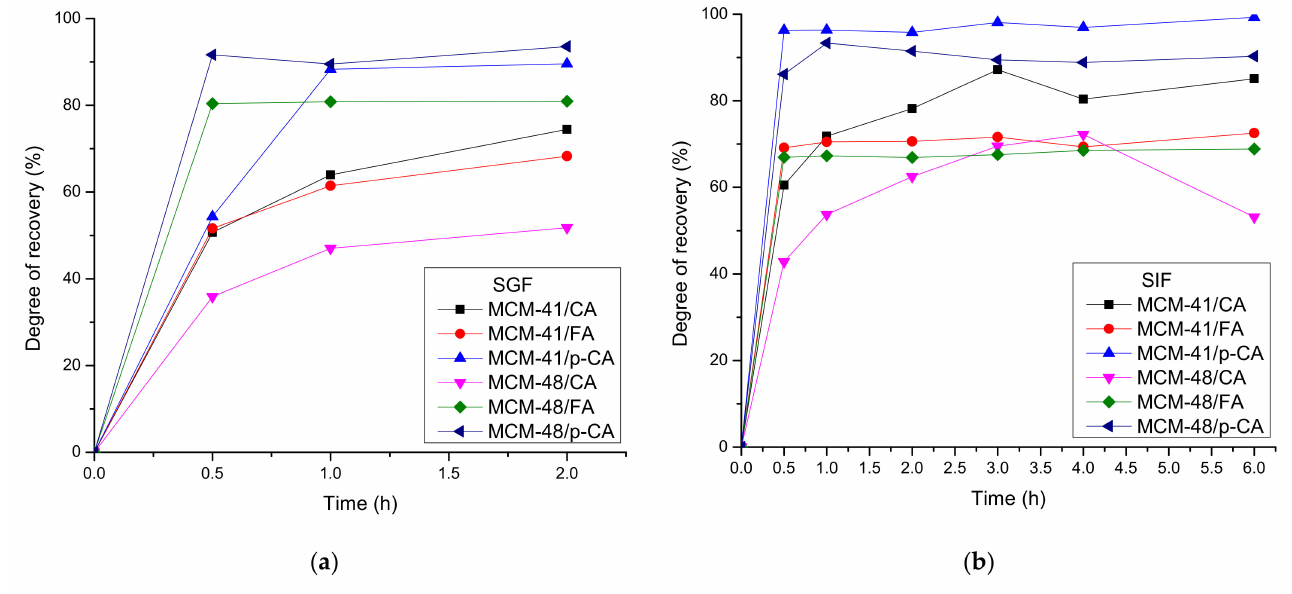
Figure 14. Degree of recovery from mesoporous silica support types MCM-41 ( a ) and MCM-48 ( b